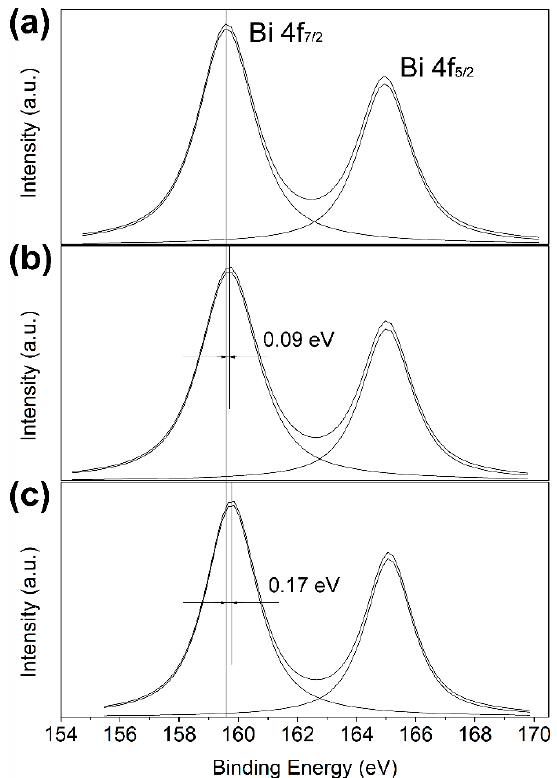
Figure 7. XPS spectra of the Bi4f region for ( a ) BiOBr virgin, ( b ) BiOBr collected after 30 ‐ min reaction time and ( c ) BiOBr collected after 60 ‐ min reaction time. BiOBr dose 0.5 g ∙ L − 1 , [CBZ] 0 = 5 μ M, [PMS] 0 = time and ( c ) BiOBr collected after 60-min reaction time. BiOBr dose 0.5 g · L − 1 , [CBZ] 0 = 5 µ M, 4.0 mM, pH = 7.0, T = 24 °C. [PMS] 0 = 4.0 mM, pH = 7.0, T = 24 ◦